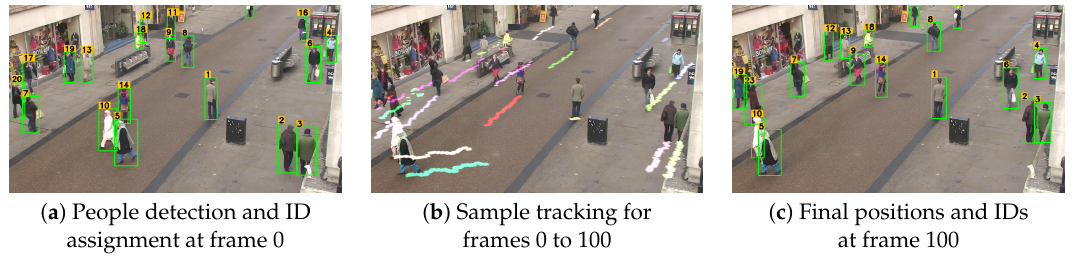
Figure 7. People detection, ID assignment, tracking and moving trajectory